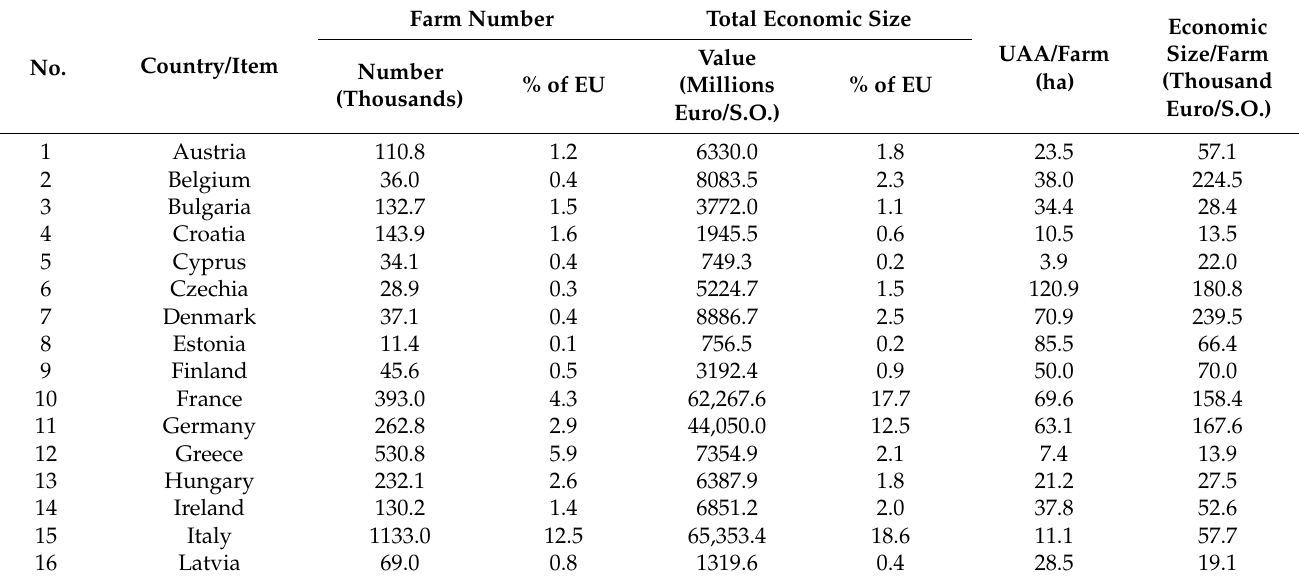
Table 2. Main indicators regarding farms and their economic size for EU, 2020.